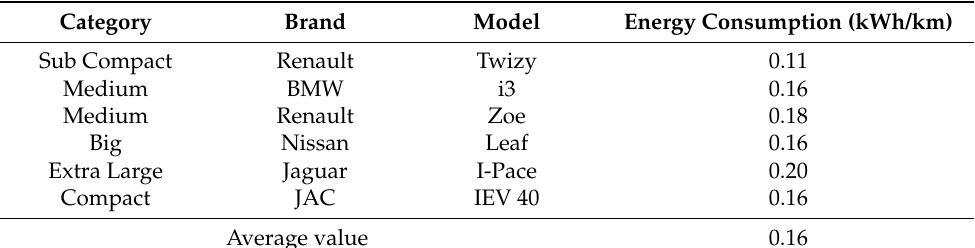
Figure 10. Estimated average battery consumption, in kWh/km. Source: JCR and Institute for Energy and Transport [25]. Table 2. EVs Energy Consumption: Based on Inmetro data [24].